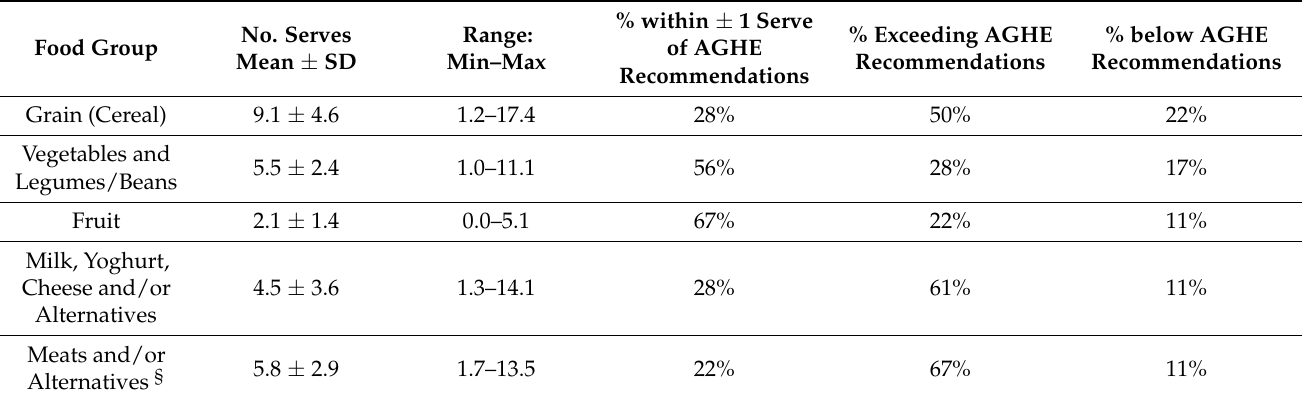
Table 3. Mean and Range of Serves of Food Groups Consumed by Women and Percentage of Women that Met the AGHE Food Group Serving Recommendations of Pregnant Women Aged 19–50